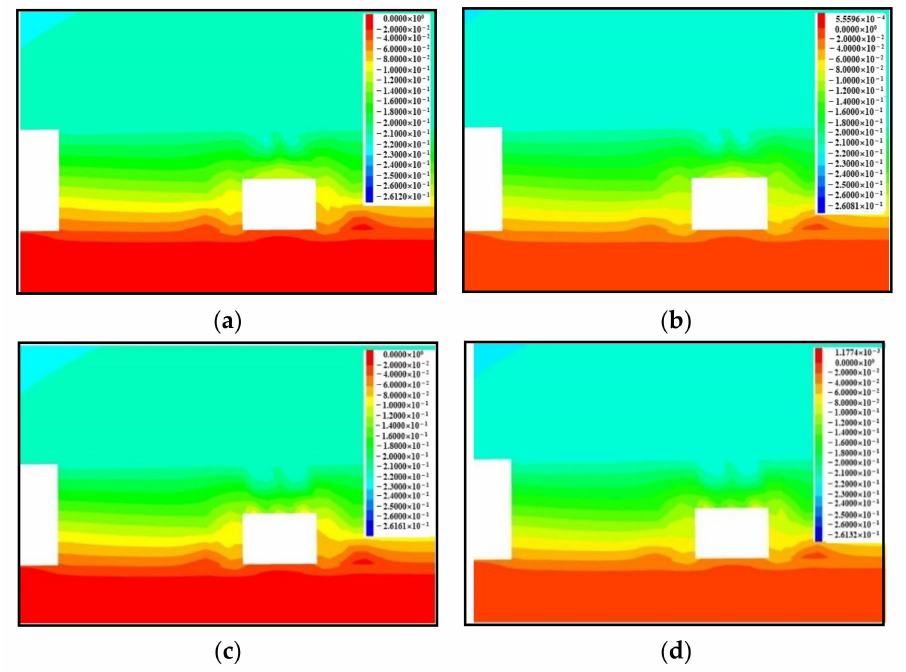
Figure 12. Cloud map of vertical deformation of the gob-side roadway: ( a ) Scheme 1; ( b ) Scheme 2; ( c ) Scheme 3; ( d ) Scheme 4.